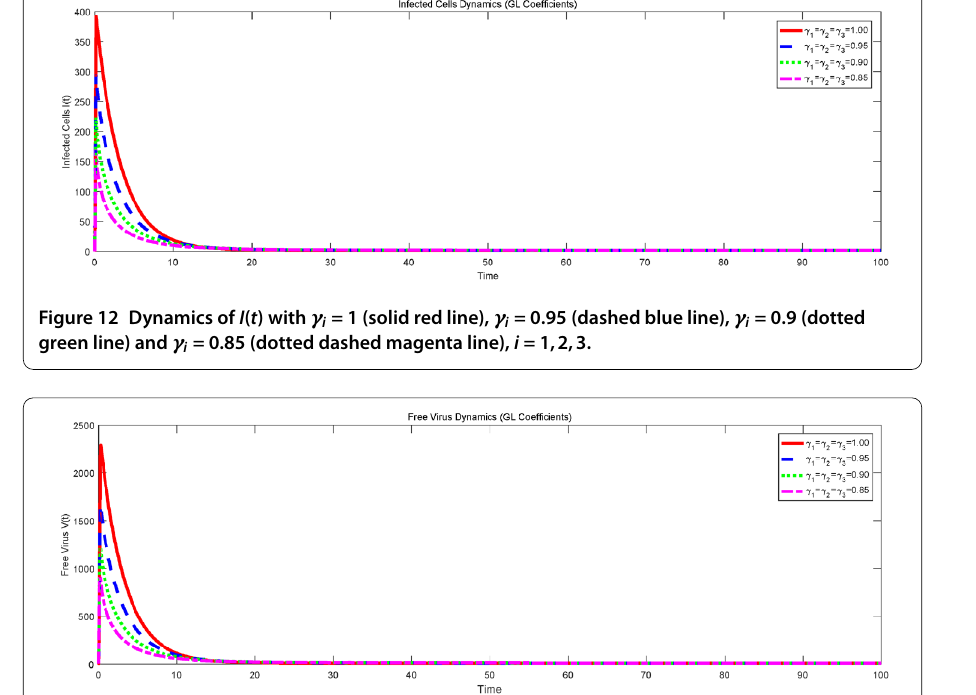
Figure 13 Dynamics of V ( t ) with γ i = 1 (solid red line), γ i = 0.95 (dashed blue line), γ i = 0.9 (dotted green line) and γ i = 0.85 (dotted dashed magenta line), i =